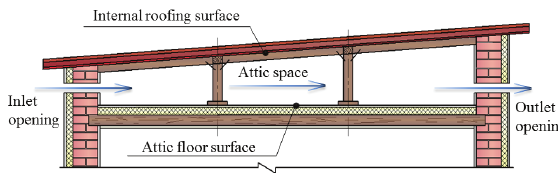
Fig. 1. Scheme of the single-pitched (mono-pitched) attic